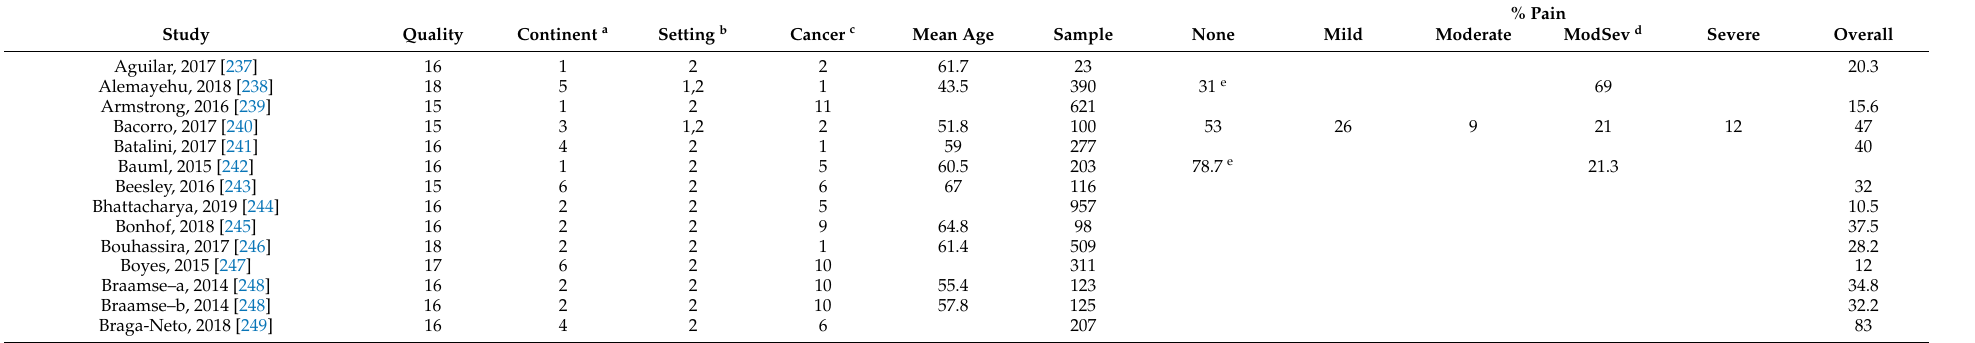
Table 8. Pain prevalence including patients in different phases of treatment (Group 7) ( n =